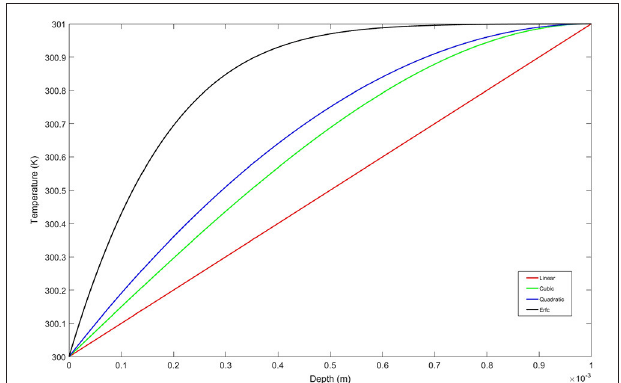
FIGURE 5 | Model temperature distributions (thermal stratification) for constant surface temperature condition T 0 300K and T d 301K at the edge = = of the thermal boundary layer at a depth of y 1 10 − 3 m. The curves blend = × into a constant temperature profile at y 1 10 − 3 m that extends to the = × domain depth at y 0.5m. The parameter δ in Equation (9c) was adjusted so = that the absolute error of T (y